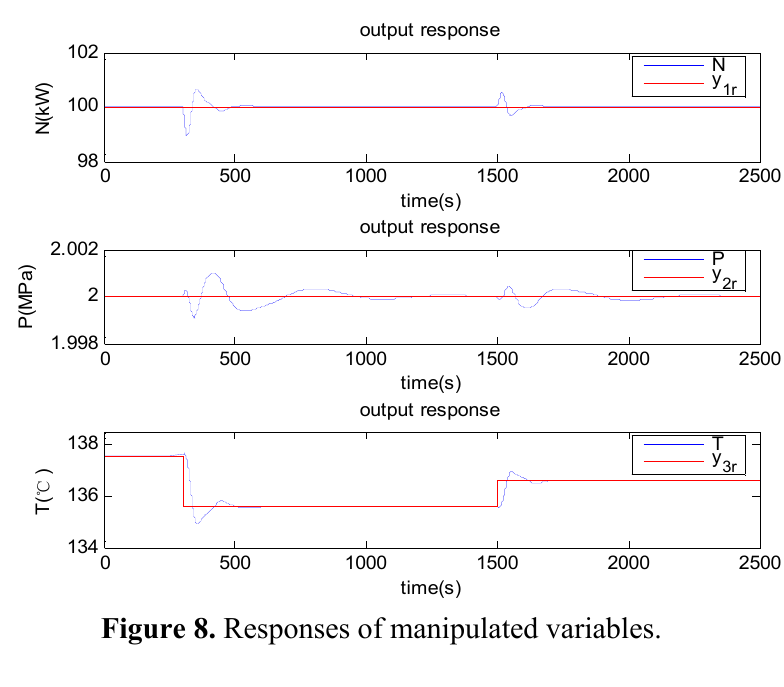
Figure 7. Responses of controlled variables.